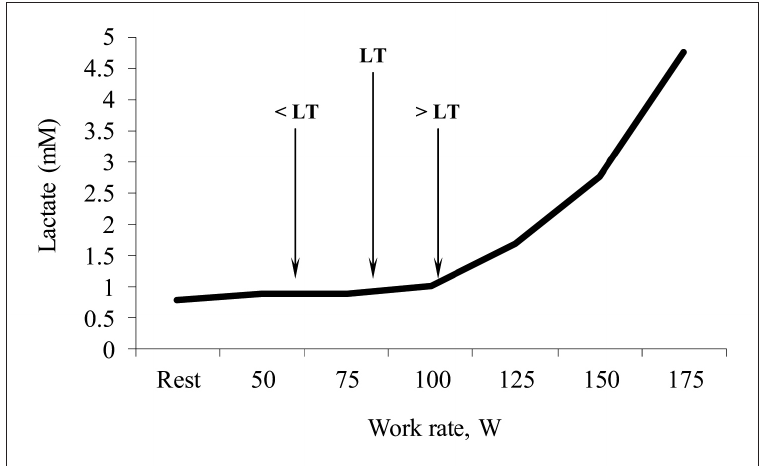
Figure 1. Lactate threshold (LT) and relative work intensity estimation